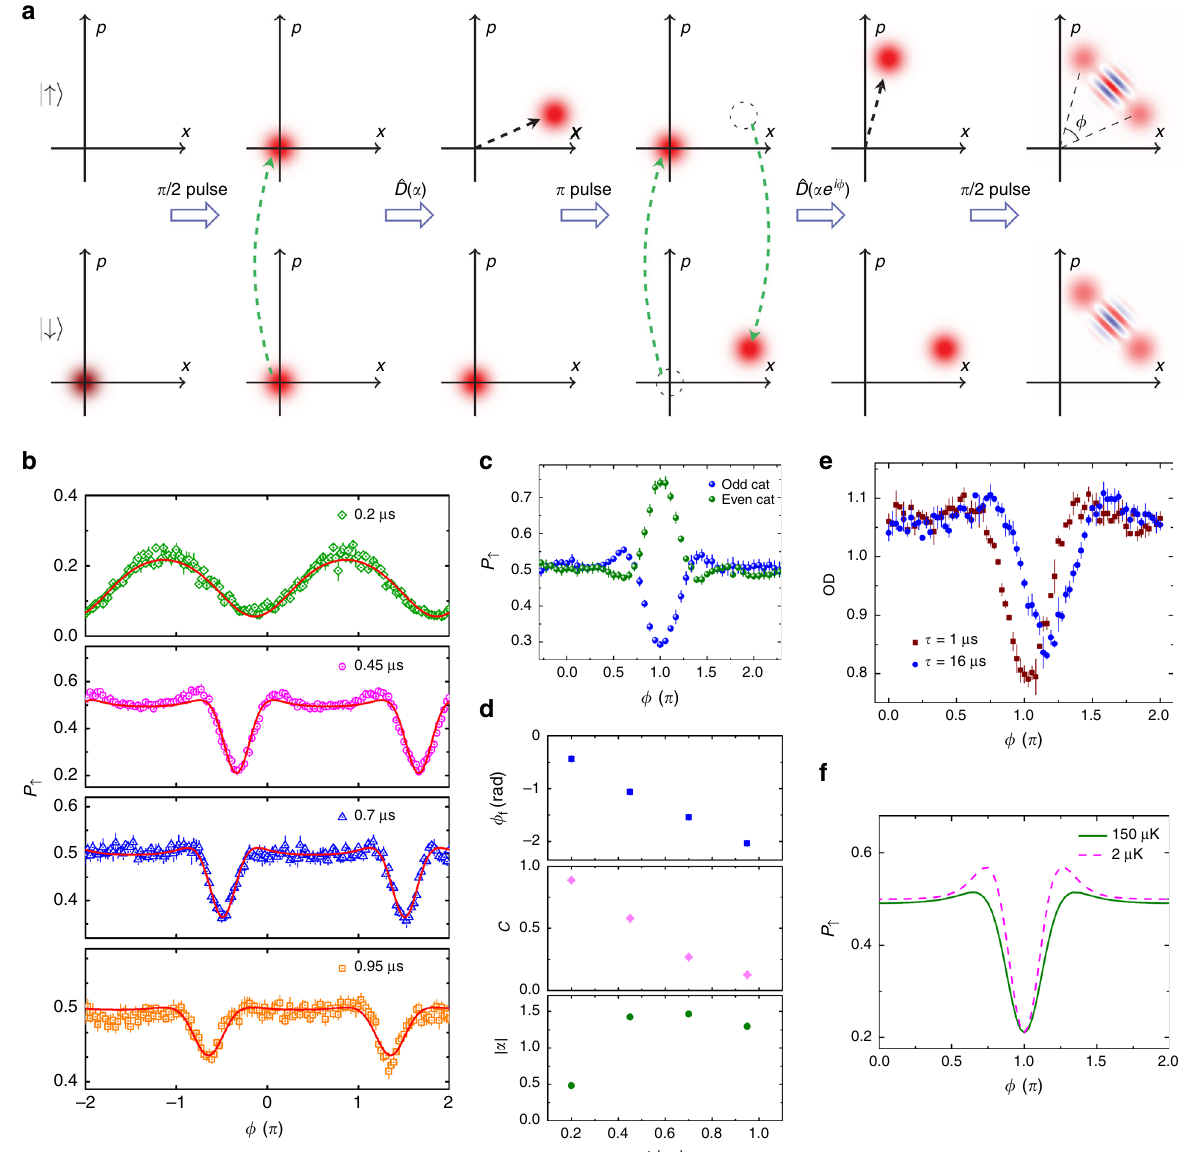
Fig. 4 SC state interferometer. a Protocol for creating the SC state in phase space representation. The top and bottom columns represent | ↑ > and | ↓ >, respectively. The circles in red indicate the uncertainty in the ground state and the coherent state. The microwave π /2 and π pulses are used to manipulate the internal spin states. The displacement operator D ̂ ( α ) and D ̂ ( α e i ϕ ) are created by driving lasers pulses. b Interference fringes of the SC state interferometer. The population of atoms in | ↑ > state P ↑ is measured with the relative phase ϕ of the two driving lasers pulses for different pulse durations. Error bars are the standard error of the mean of four experimental runs. c Even and odd SC states. The population of atoms in | ↑ > state P ↑ is measured with the relative phase ϕ of the two driving lasers pulses for δ M = 0 (odd SC state) and δ M = π (even SC state). The driving lasers pulse duration is 0.45 μ s. Error bars are the standard error of the mean of four experimental runs. d Fitting parameters of Eq. (4) for the experimental data in panel b is plotted against different driving lasers pulse duration. e Measurements of the | ↑ > state population P ↑ in cat interferometer operation versus phase ϕ with additional free evolution time τ . The total free evolution time between the two driving lasers pulses for τ = 1 μ s is 16 μ s. Error bars are the standard error of the mean of four experimental runs. f Simulation of the temperature effect on the SC state interferometer. The simulation uses the fi tted parameters for t = 0.45 μ s in panel d . The 1/ e Gaussian radius of the atomic cloud in the radial direction is 0.9 μ m and 8 μ m for 2 μ K and 150 μ K,